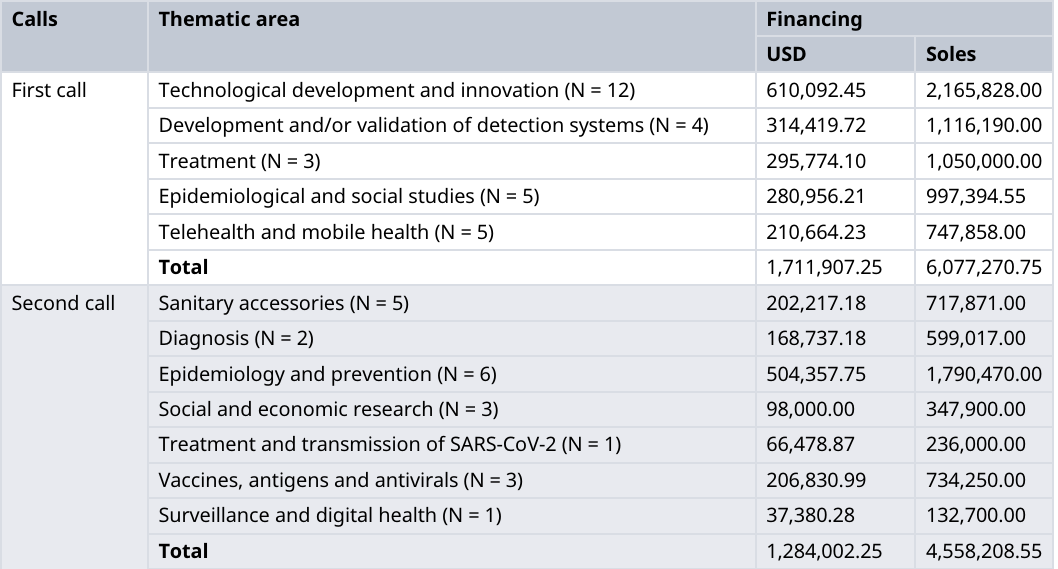
Table 3. Financing distribution according to thematic in both